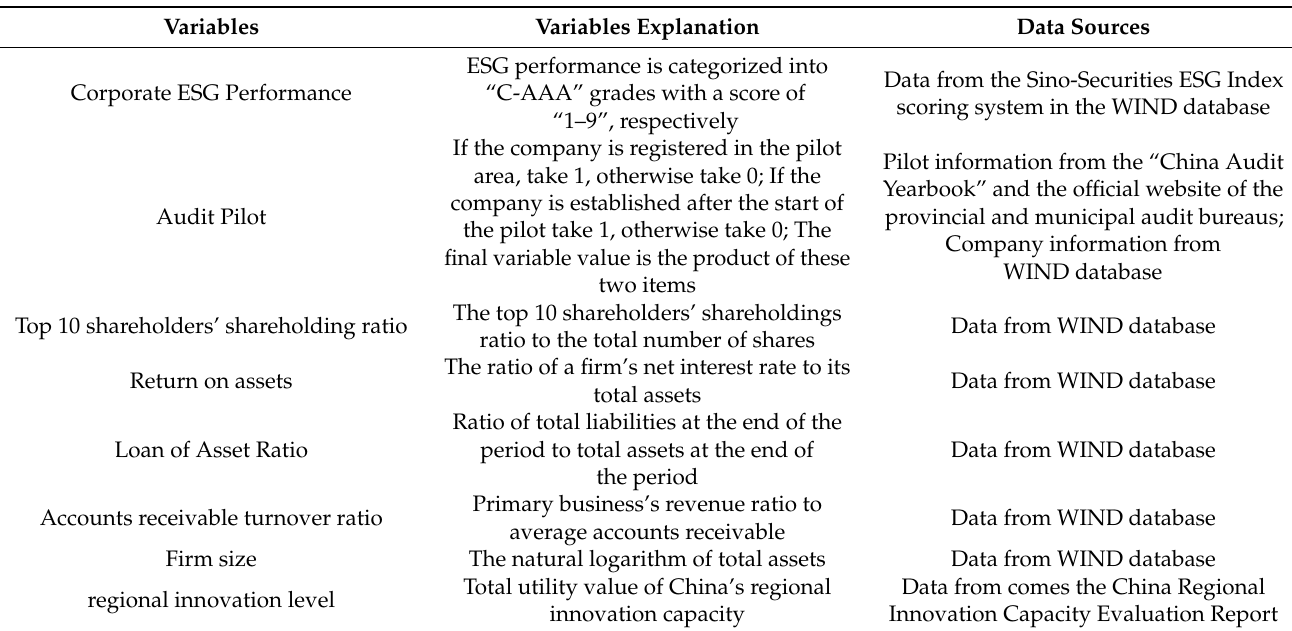
Table 2. Variable explanation and